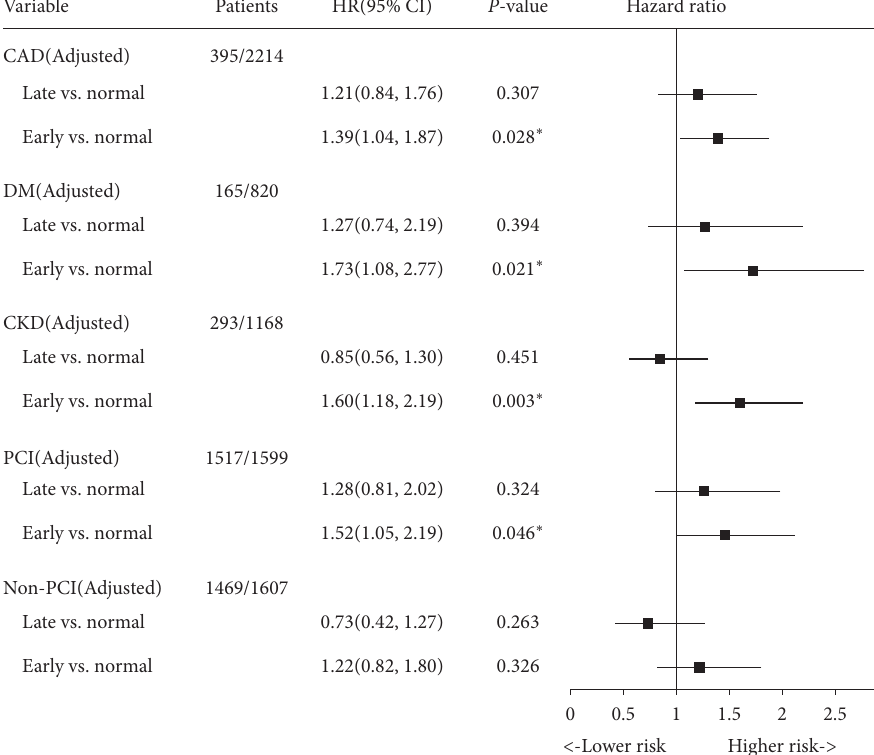
Figure 4: Multivariable analysis for mortality stratified according to early CA-AKI, late CA-AKI, and normal in patients with CAD, CKD, DM, PCI, and Non-PCI. CA-AKI defined as an increase ≥ 50% or ≥ 0.3mg/dL from baseline. Adjusted for age ≥ 75, male, acute myocardial infarction, chronic heart failure, hypertension, anemia, contrast media volume, beta-blocker uses, statin use, and diuretic